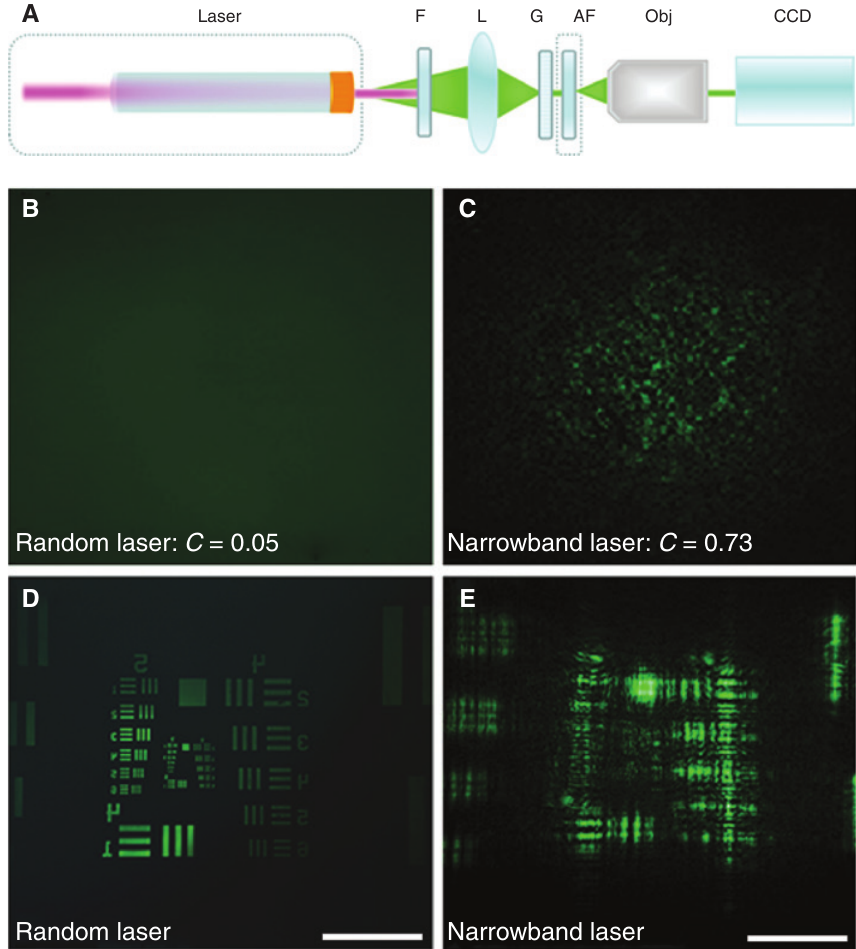
Figure 6: Imaging systems based on the proposed laser device. (A) Schematic of the experimental setup. F, filter; L, lens; G, ground glass; AF, AF resolution test chart; Obj, objetive. The recorded images of a ground glass illuminated by (B) the perovskite random laser and (C) a 532-nm continuous laser source. The images of the AF resolution test chart illuminated by (D) the perovskite random laser source and (E) a 532-nm continuous laser source. The scale bar is 500 μ